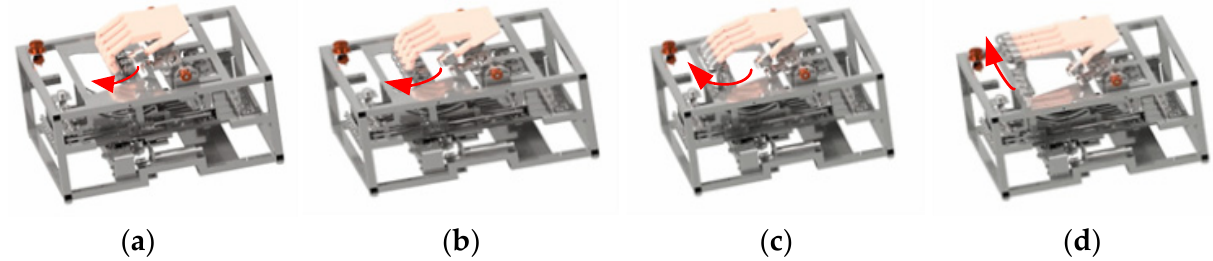
Figure 1. Flexion/extension training: ( a ) start position; ( b ) middle position 1; ( c ) middle position 2; ( d ) end position.